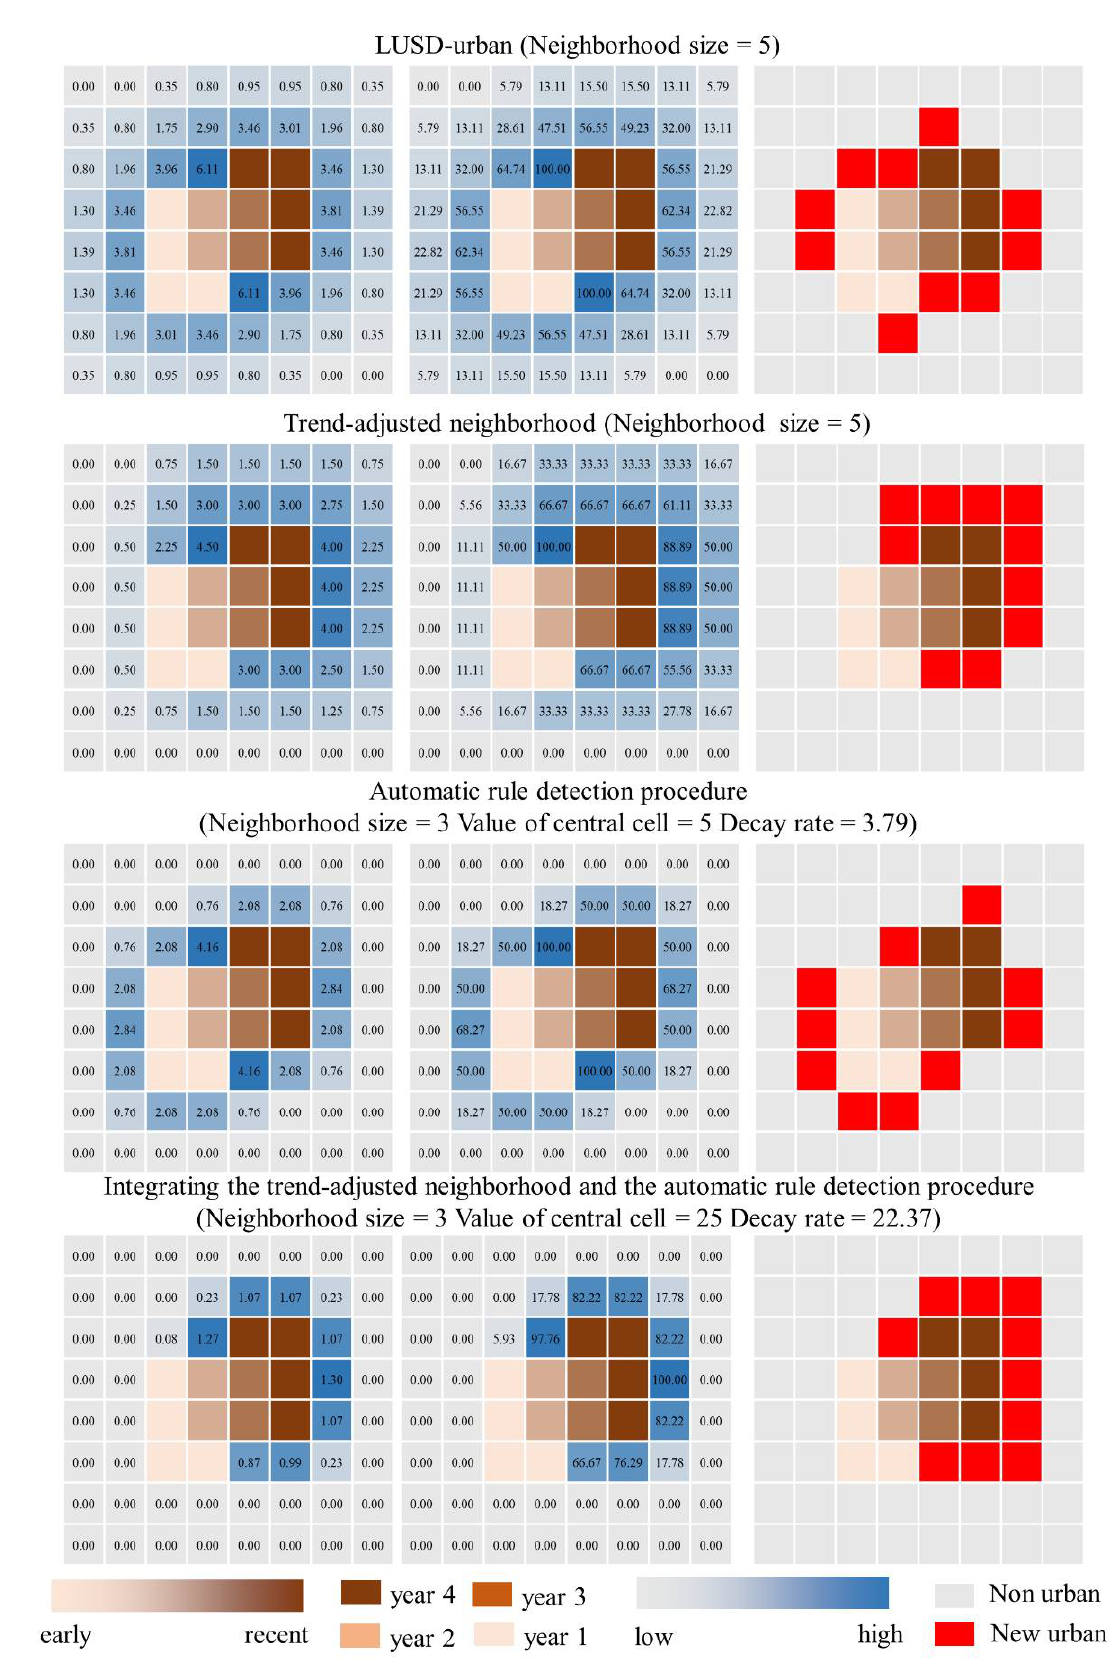
Figure 3. Examples of the neighborhood calculation in the original and improved LUSD-urban model.